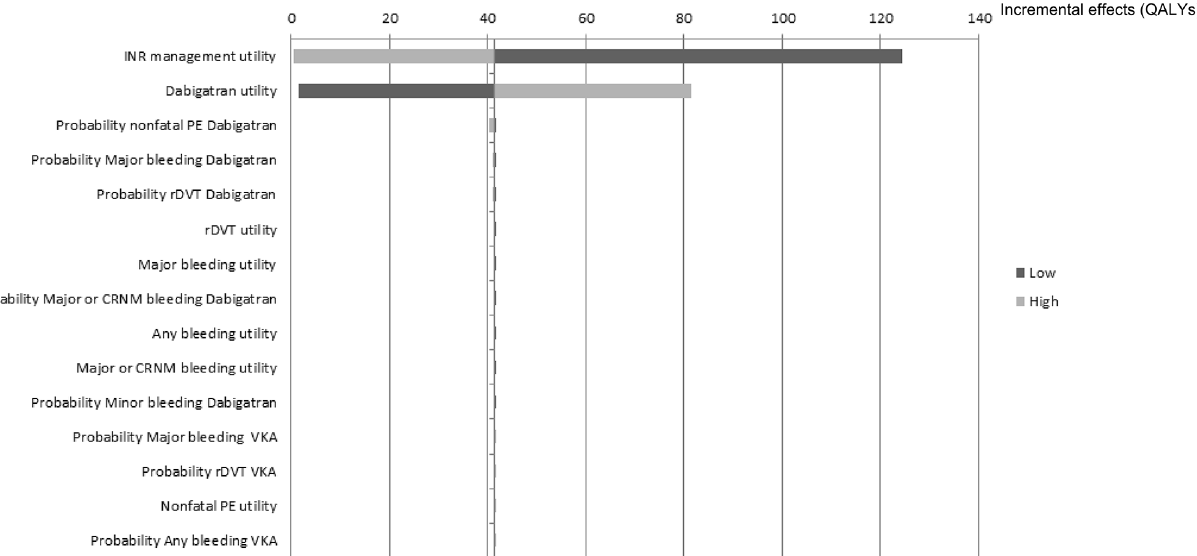
Fig 4. Tornado diagram illustrating the impact on the incremental effects from sensitivity analyses for dabigatran vs. vitamin-K antagonists. Light grey bars denote influence of the high value of the 95% confidence interval range and dark grey bars denote influence of the low value for parameters investigated. The solid vertical line represents the base case incremental QALYs for dabigatran compared to VKA. Horizontal bars indicate the range of incremental QALYs obtained by setting each variable to the values shown while holding all other values constant. INR, international normalized ratio; PE, pulmonary embolism; rDVT, recurrent deep vein thrombosis; VKA, vitamin K antagonist; CRNM, clinically relevant non-major.